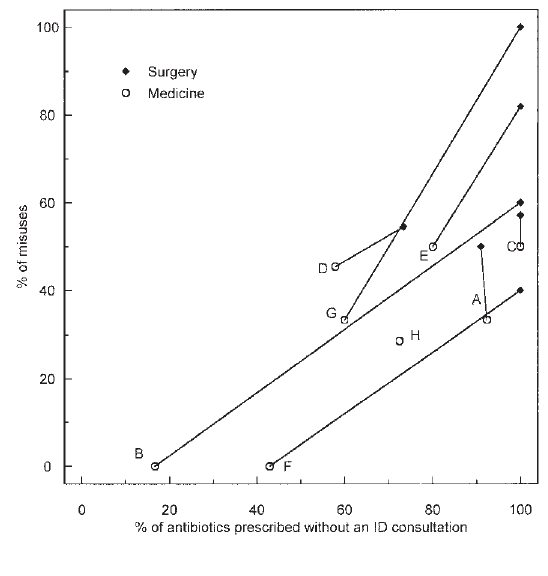
Relation of percent- age of antibiotic (AB) misuses to percent- age of AB prescribed without ID consul- tation, by hospital (A-H) and by ward.